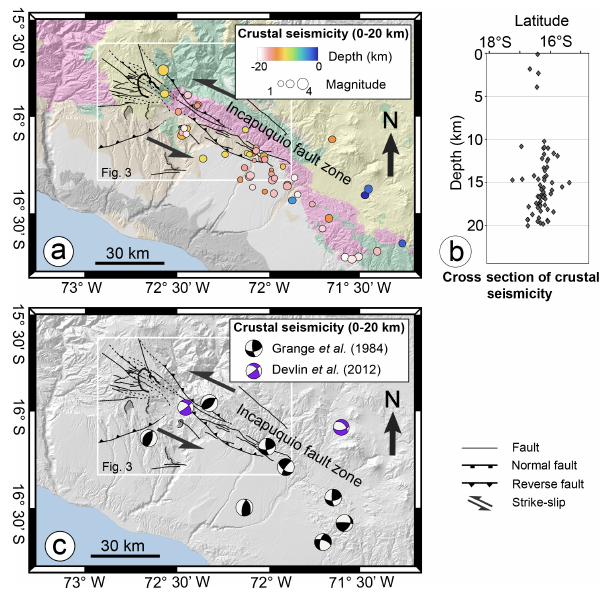
Figure 2. Regional crustal seismicity and focal mechanisms. (a) Crustal seismicity (depth <20km) and faults are represented on the geological map of South Peru (modified from Roperch et al., 2006; INGEMMET, 2001). (b) Cross section showing the ver- tical cluster of earthquakes. (c) Focal mechanisms from Grange et al. (1984) and Devlin et al. (2012); the kinematics of the Incapuquio fault system are indicated by black